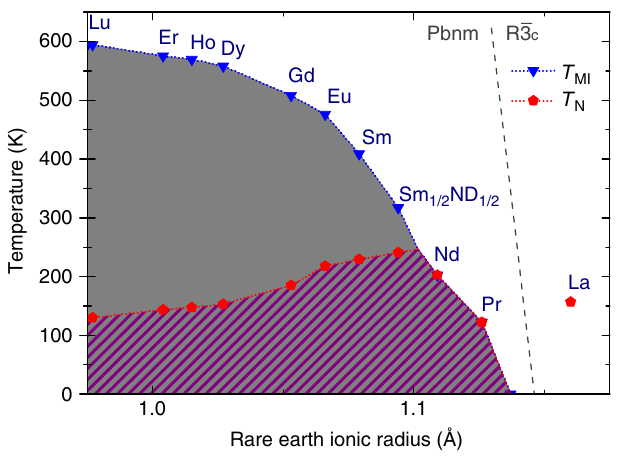
Fig. 6 Tentative R NiO 3 phase diagram. The blue triangles indicate the metal-insulator transition temperatures T MI associated with the onset of charge ordering and the appearance of monoclinic distortions. The red symbols indicate the Néel temperatures T N associated with the onset of antiferromagnetic ordering. Data points for other R than La were taken from literature 24,32 . The gray dashed curve subdivides orthorhombic (monclinic) and rhombohedral